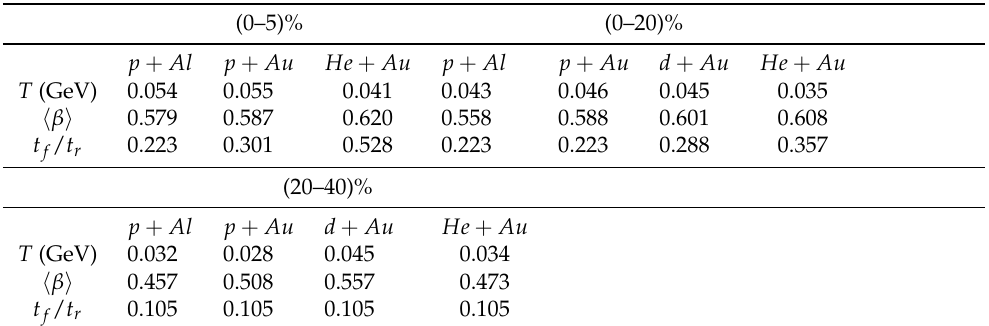
Table 1. Adjusted parameters’ equilibrium temperature, T = T eq , which characterizes the Boltzmann local equilibrium distribution; the average speed, (cid:104) β (cid:105) ; and the ratio of the freeze-out and relaxation times, t f / t r . Results are presented for three classes of